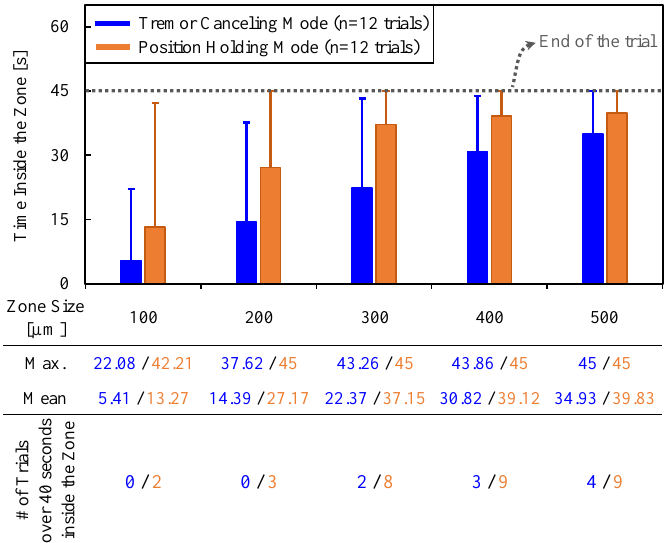
Figure 12. The total time that the needle tip was maintained inside various sizes of zones around the puncture point using the TCM (in blue) versus the PHM (in orange) features. The solid bars show the mean, and the error bars represent the maximum values. The active position holding helps in maintaining the needle tip inside the vein for a significantly longer time, especially for veins smaller than 300 µm [62]. The length of stay within each zone for all users with the TCM versus the PHM are compared in Figure 13. In contrast to the first user, the limited training that both user 2 (ophthalmology fellow) and user 3 (vitreoretinal surgeon) received on the robotic system is a factor affecting their performance.